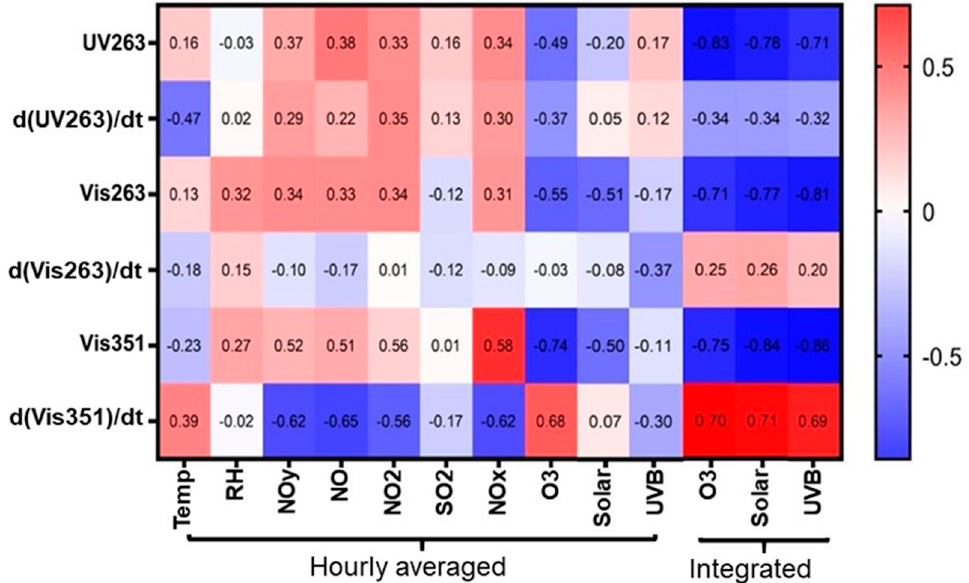
Figure 7. Heatmap of Pearson’s R values showing positive (red) and negative (blue) correlations between the intensities of three fluorescence bands and their first derivative (change rates), and the measured ambient conditions and pollutant levels for experiments involving MS2 aerosol.